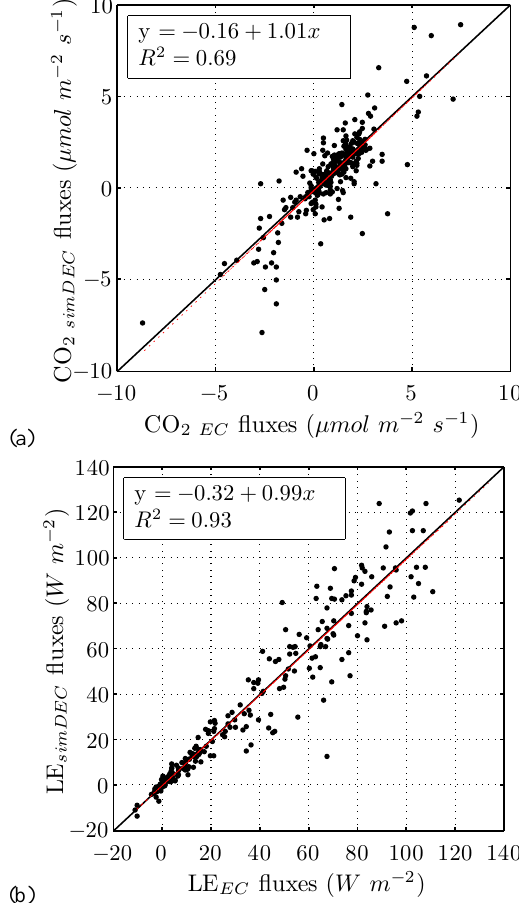
Fig. 8. (a) Eddy covariance vs. simulated disjunct eddy covari- ance CO 2 fluxes (µmolm − 2 s − 1 ) and (b) latent heat (Wm − 2 ) . Both graphs report data from the entire field campaign (i.e. from 9 June to 17 June 2011). Solid line is the 1 : 1 line and red dashed line is the linear